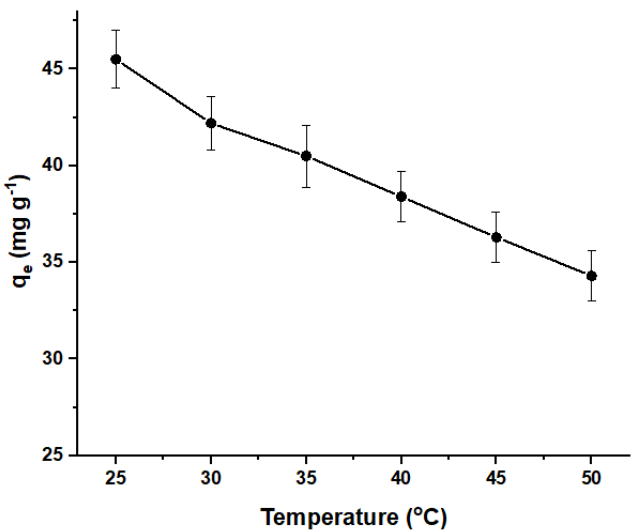
Figure 8. Effect of temperature on the removal of COD by activated carbon.